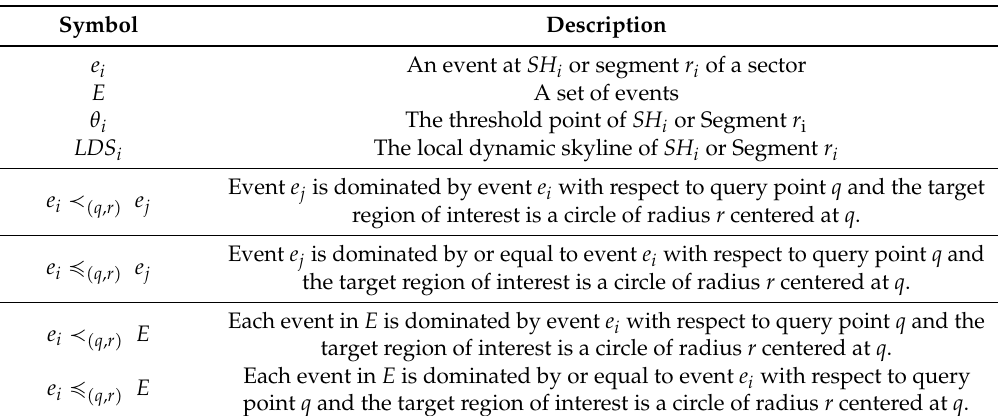
Table 3. Skyline Notation.